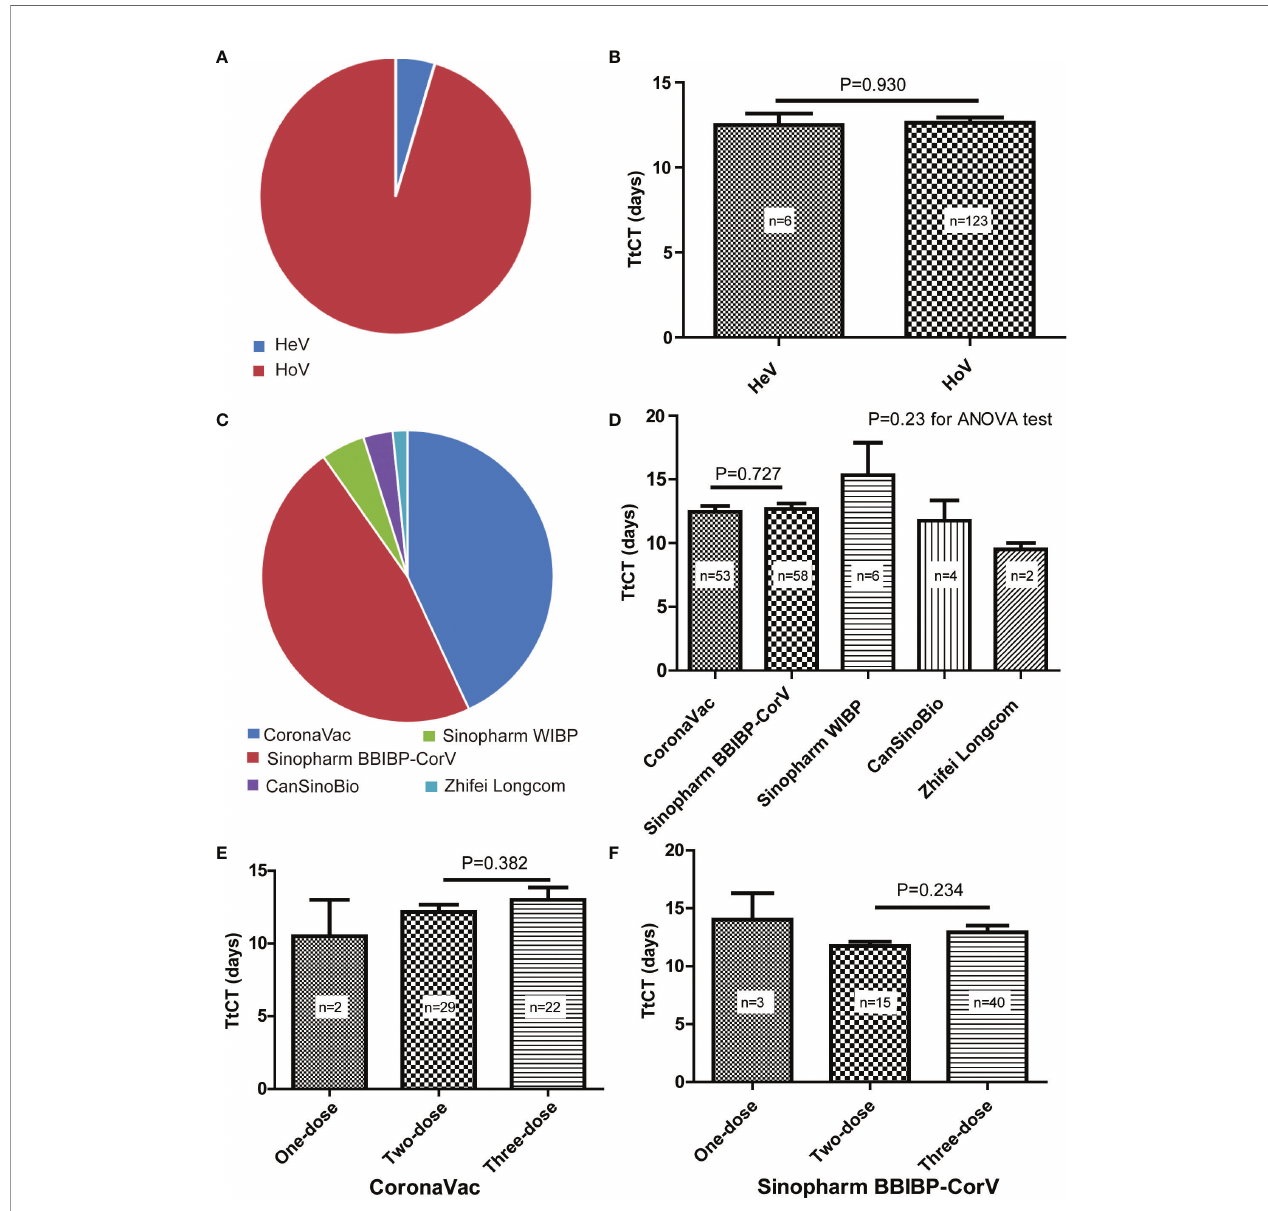
FIGURE 2 | Details of SARS-CoV-2 vaccination for selected patients. (A) Proportions of heterogeneous vaccination (HeV) and homologous vaccination (HoV). (B) Comparison of the time to target cycle threshold value (TtCT) between HeV and HoV. (C) Proportions of different vaccines for homologous vaccination. (D) Comparison of TtCT among different vaccines for homologous vaccination. (E) Comparison of TtCT between the two-dose primary vaccination and the three-dose booster vaccination of CoronaVac. (F) Comparison of TtCT between two-dose primary vaccination and three-dose booster vaccination of Sinopharm